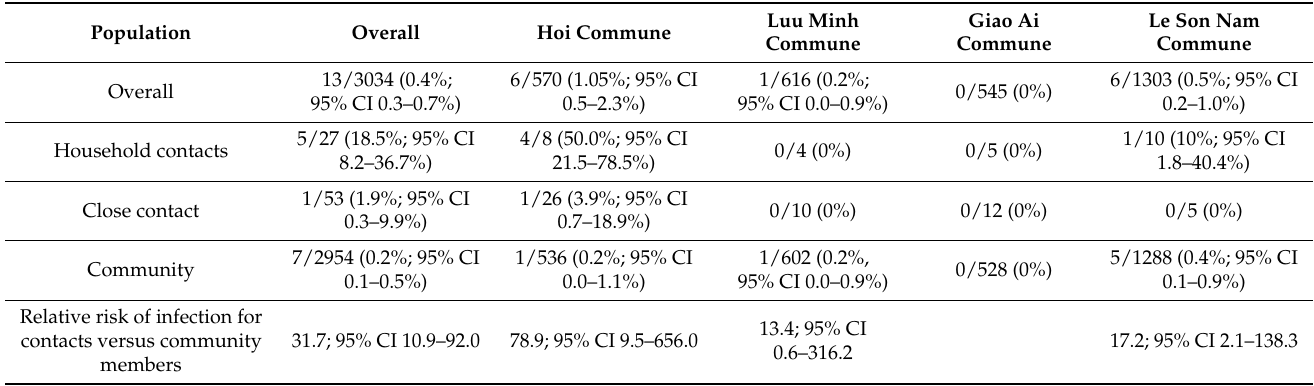
Table 4. Prevalence of seropositivity within high-risk populations, grouped by cluster.